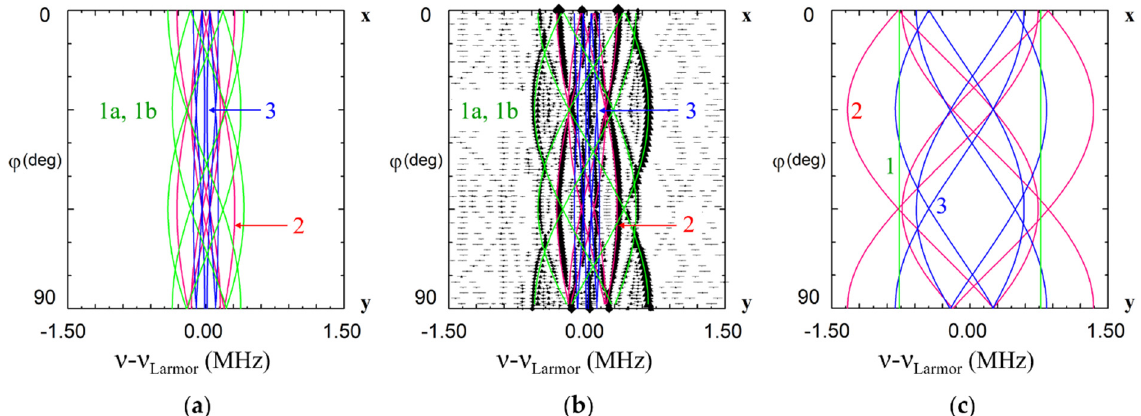
Figure 6. Angular dependence of electron nuclear double resistance (ENDOR) frequencies of Li nuclei in xy plane for the Nd 13+ center in LiNbO 3 . The green, red and blue curves—calculated frequencies for Li nuclei of the 1st, 2nd and 3rd shells based on dipole-dipole interaction for Nd 3+ Li ( a , b ), and Nd 3+ Nb ( c ). ENDOR frequencies represented on the part ( b ) were measured at magnetic fields corresponding to the position of dominant EPR line #1 on Figure 2 ( B = 820 mT for ν = 34.445 GHz, rhombs, and B = 228 mT for ν = 9.500 GHz, triangles). ν Larmor is Larmor frequency of 7 Li nuclei.